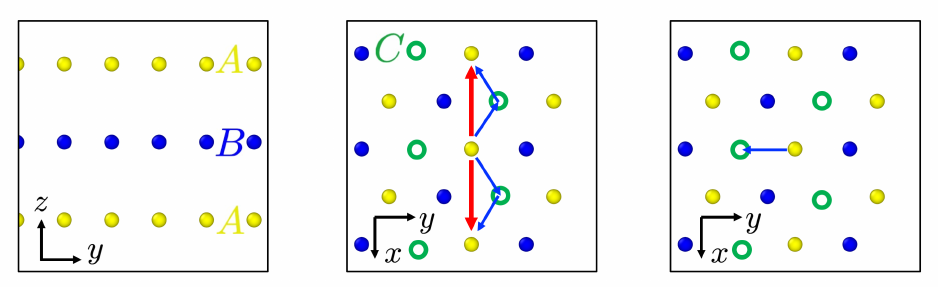
Figure 7. Left: side view of twin boundary (blue) and adjacent (111) planes. Middle and right: top view of the same three atomic layers showing accommodation of E xz (middle) and E yz (right) deformation via dislocation nucleation. Arrows denote perfect (red) and partial (blue) Burgers